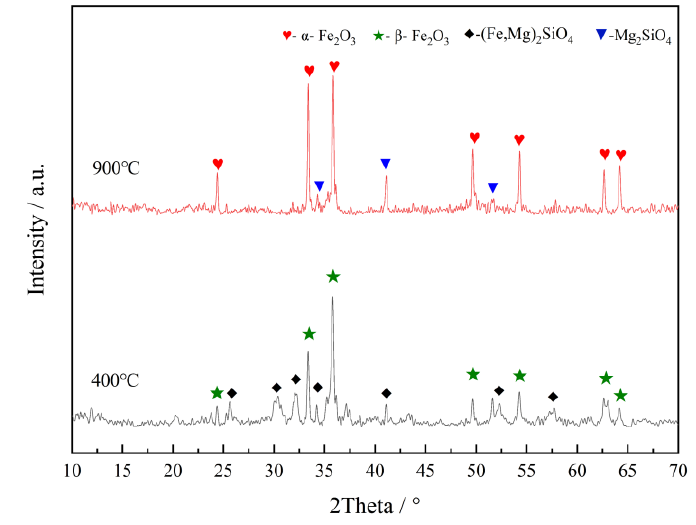
Figure 10. XRD patterns of nickel slag samples after oxidation for 30 min at 400 °C and 900 °C respectively.